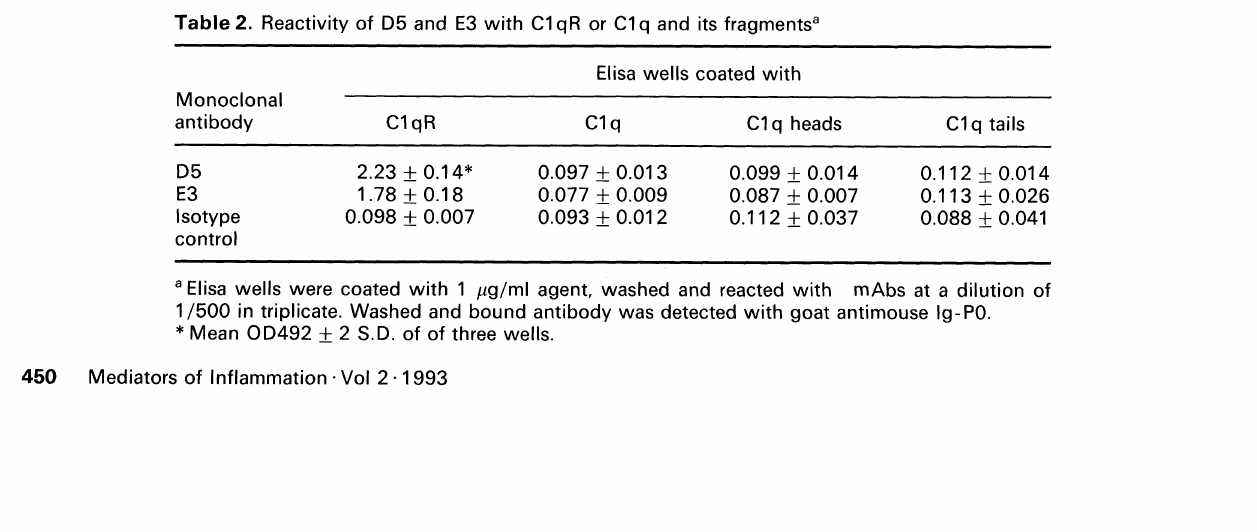
Table 2. Reactivity of D5 and E3 with ClqR or Clq and its fragments Monoclonal